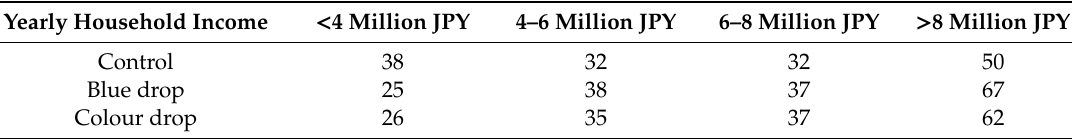
Table 2. Distribution of yearly household income level in each group.